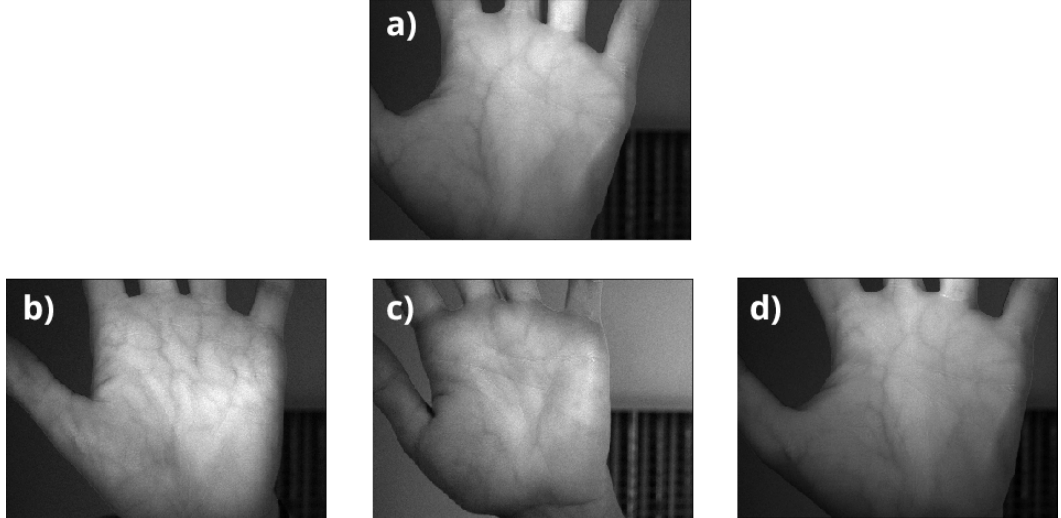
Figure 5. An example of comparison: ( a ) is the image that is captured when the user tries to authenticate itself, ( b – d ) are some samples from the database where ( b , c ) and are images of different persons and ( d ) represents a match in the